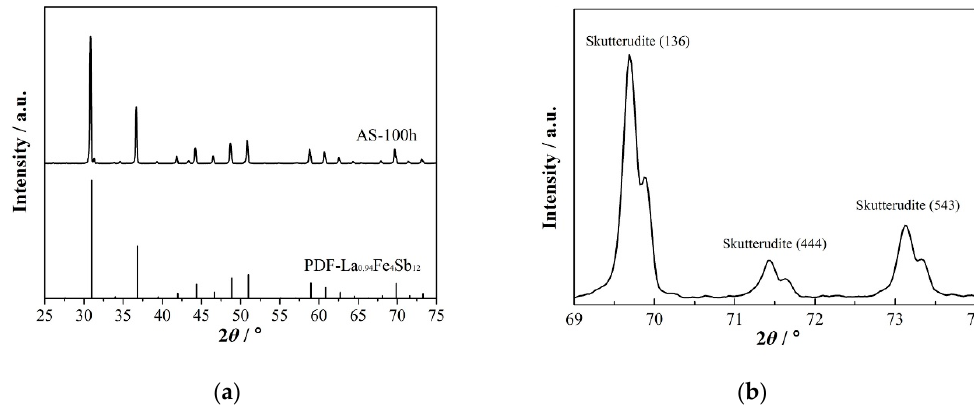
Figure 2. ( a ) The XRD pattern of the sample annealed at 973 K for 100 h. All of the peaks were indexed as the skutterudite phase. ( b ) The enlarged XRD pattern from 2-theta of 69°–74°. The spinodal twin peaks can be clearly seen.